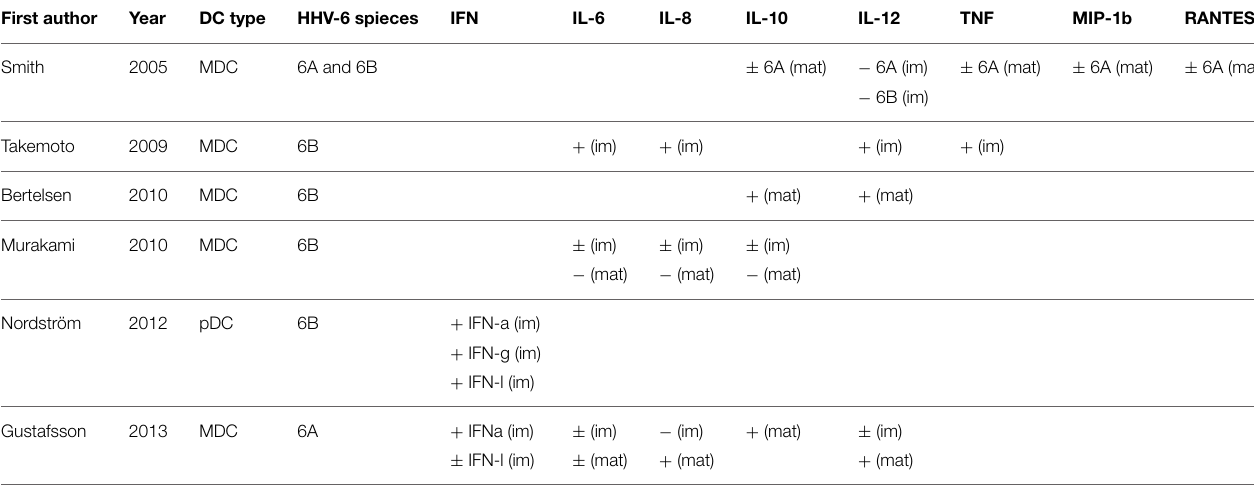
TABLE 2 | Cytokine secretion upon HHV-6